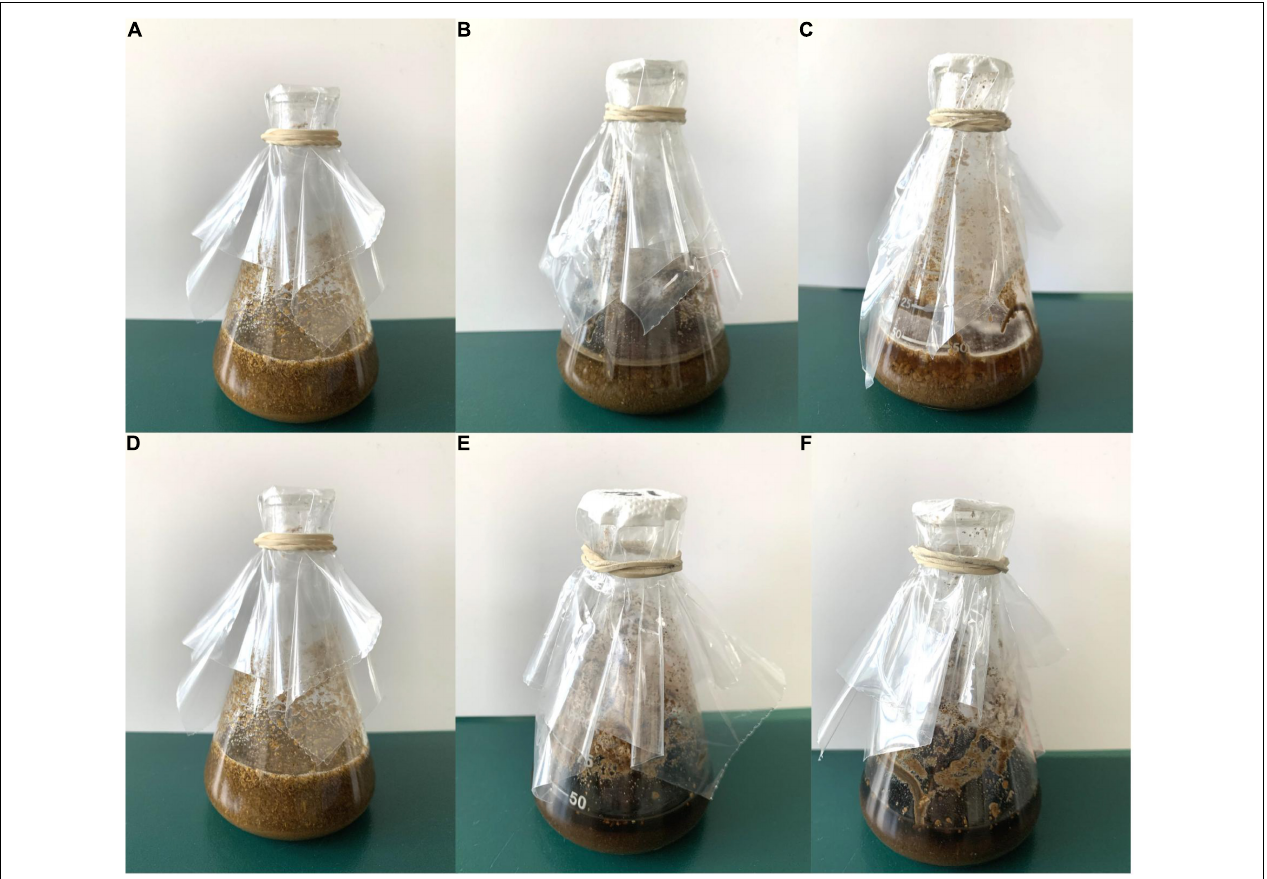
FIGURE 6 | Residue after 15 days of fermentation in liquid medium. (A) and (D) Negative control, (B) no. 1, (C) no. 6, (E) no. 9, and (F) no. 10. TABLE 2 | Total weight loss rate of residue after 15 days of hydrolysis. Negative control 1